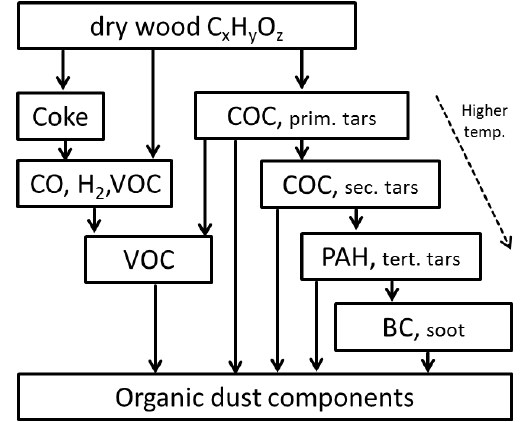
Figure 1. Ways of conversion of the hydrocarbons to organic dust components according to Nussbaumer (2010) (Weiss et al., 2014).